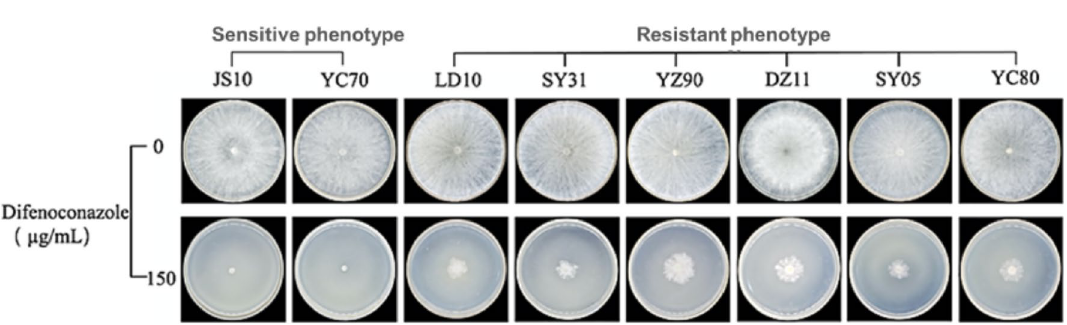
Figure 2. Mycelia colony growth of the eight Lasiodiplodia theobromae isolates on PDA plates with and without